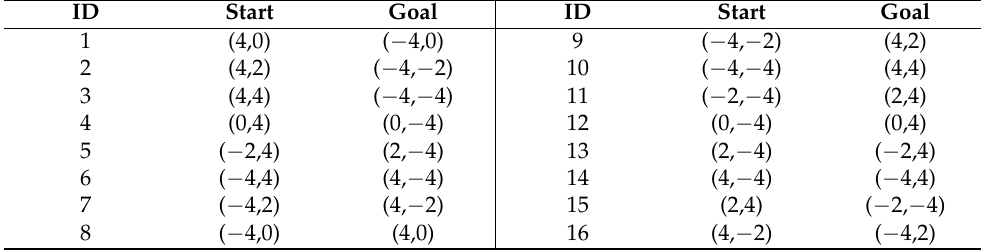
Table 1. Start and Goal of